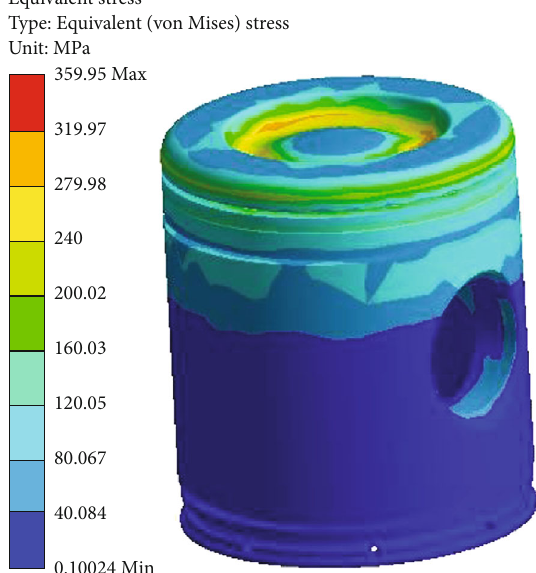
Figure 11: The von Mises stress nephogram of the piston under thermomechanical stress coupling condition.